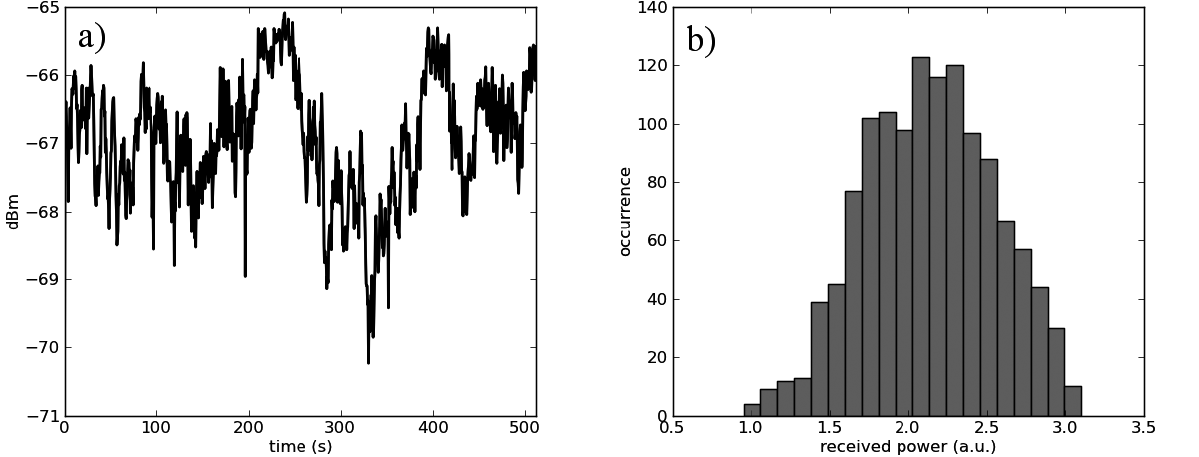
Figure 5. (a) Power observations of the radio echo reflected from the ionosphere on January 13, 2008, at 07:40 UT; (b) corresponding Nak- agami-Rice probability density distribution.